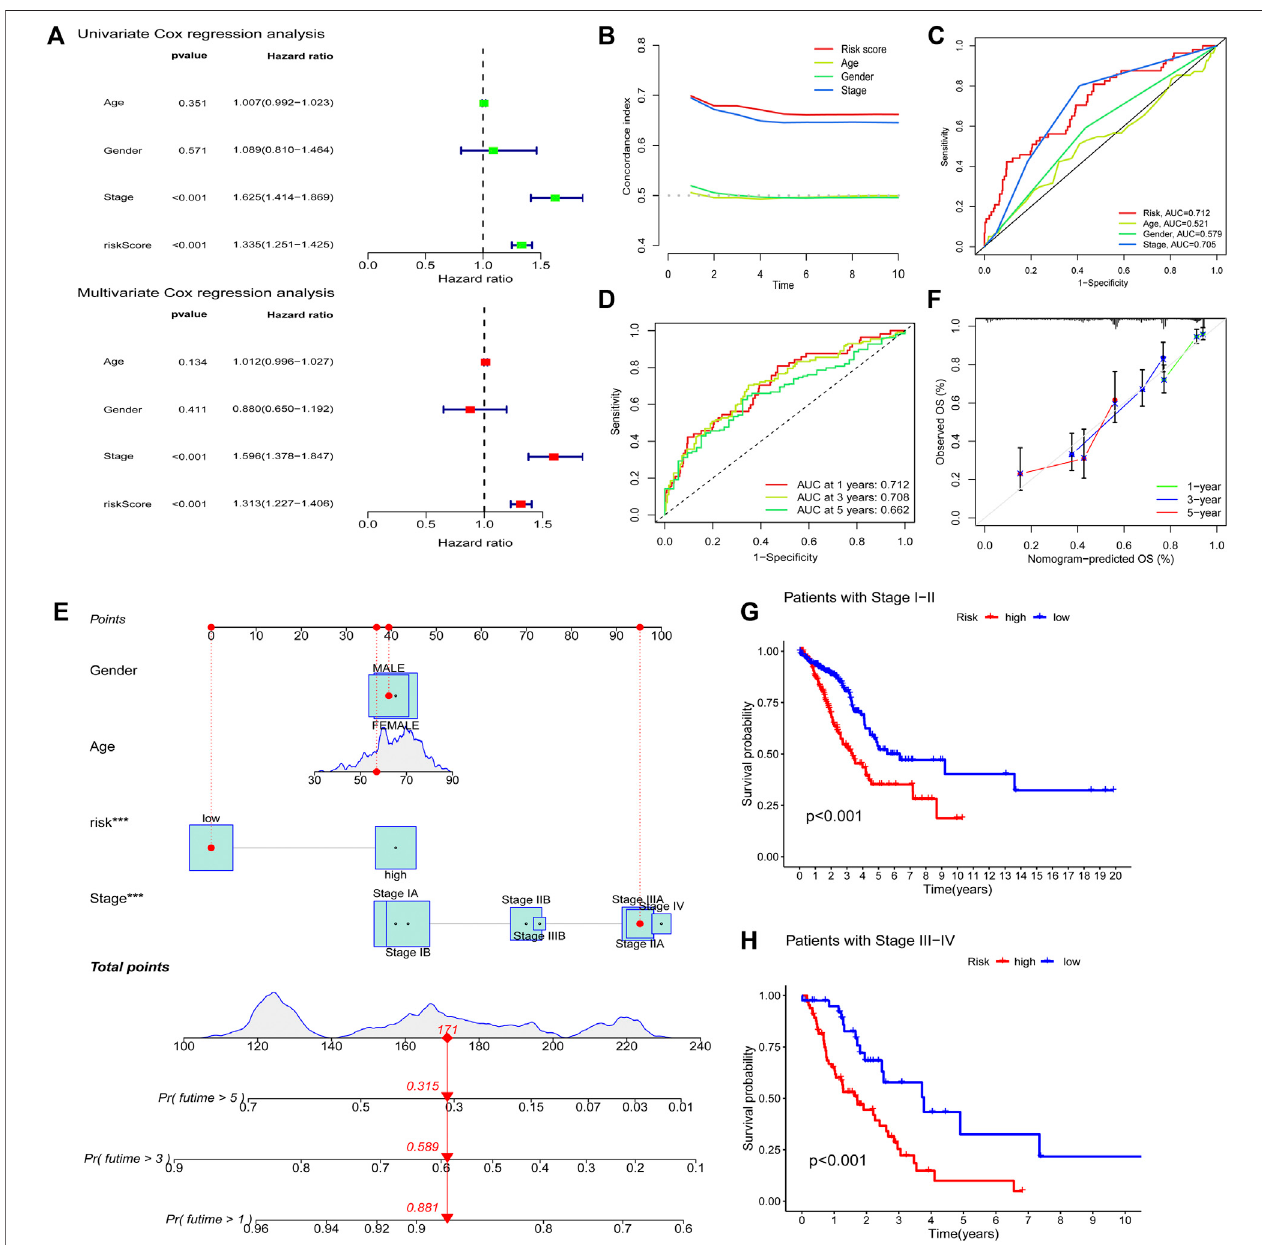
FIGURE6| Evaluating prognostic riskmodelsfor FAM-associatedlncRNAs and clinicalcharacteristicsin LUADpatients. (A) Univariate and multivariate analysisof clinical characteristics and risk scores. (B) Concordance index of risk score with clinical characteristics. (C) ROC curves of clinical features and risk scores. (D) ROC curves for 1-, 2-, and 3-years OS. (E) Nomogram predicting the probability of OS at 1, 2, and 3 years. (F) Calibration plot predicting the agreement between observed andpredictedratesofOSat1,2,and3years. (G and H) K – McurveanalysisofpatientOSaccordingtoFAM-relatedlncRNAsmodelriskinstageI-IIandstageIII-IV patients, respectively. ***, p <